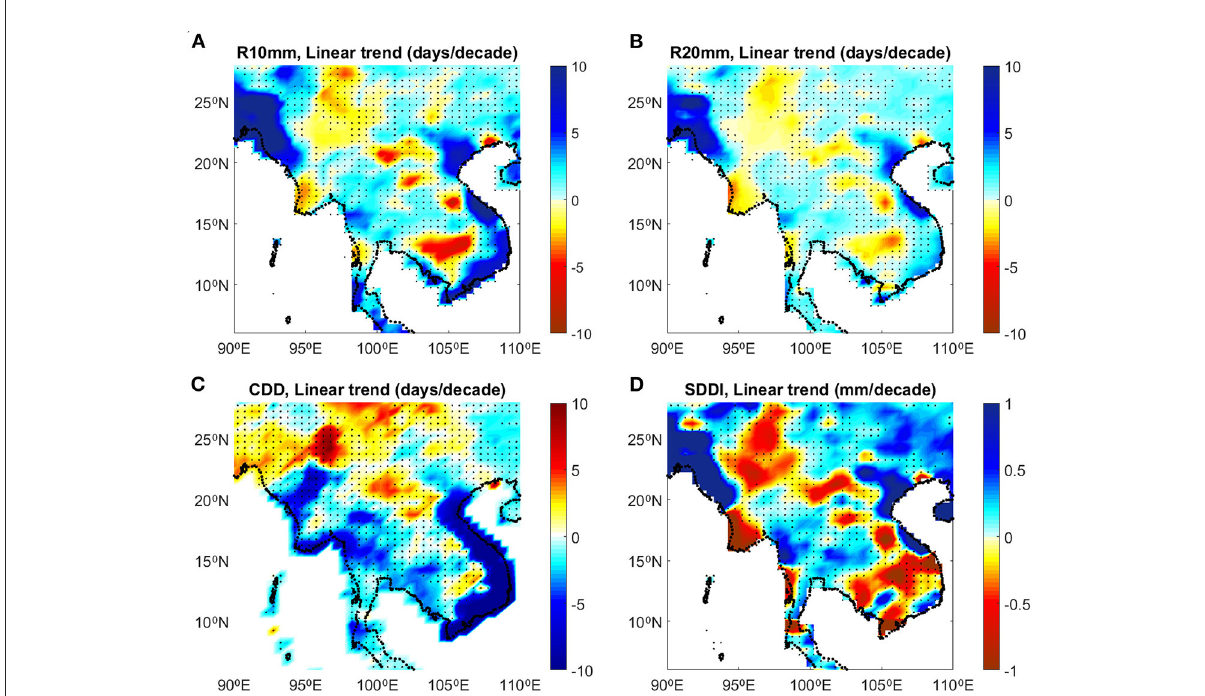
FIGURE5 Trends over 1979–2018 in extreme precipitation indices from the Global Unified Gauge-Based Analysis of Daily Precipitation–Climate Prediction Center (CPC) dataset. (A) R10mm: Number of days of heavy precipitation ( P > 10mm), (B) R20mm: Number of days of very heavy precipitation